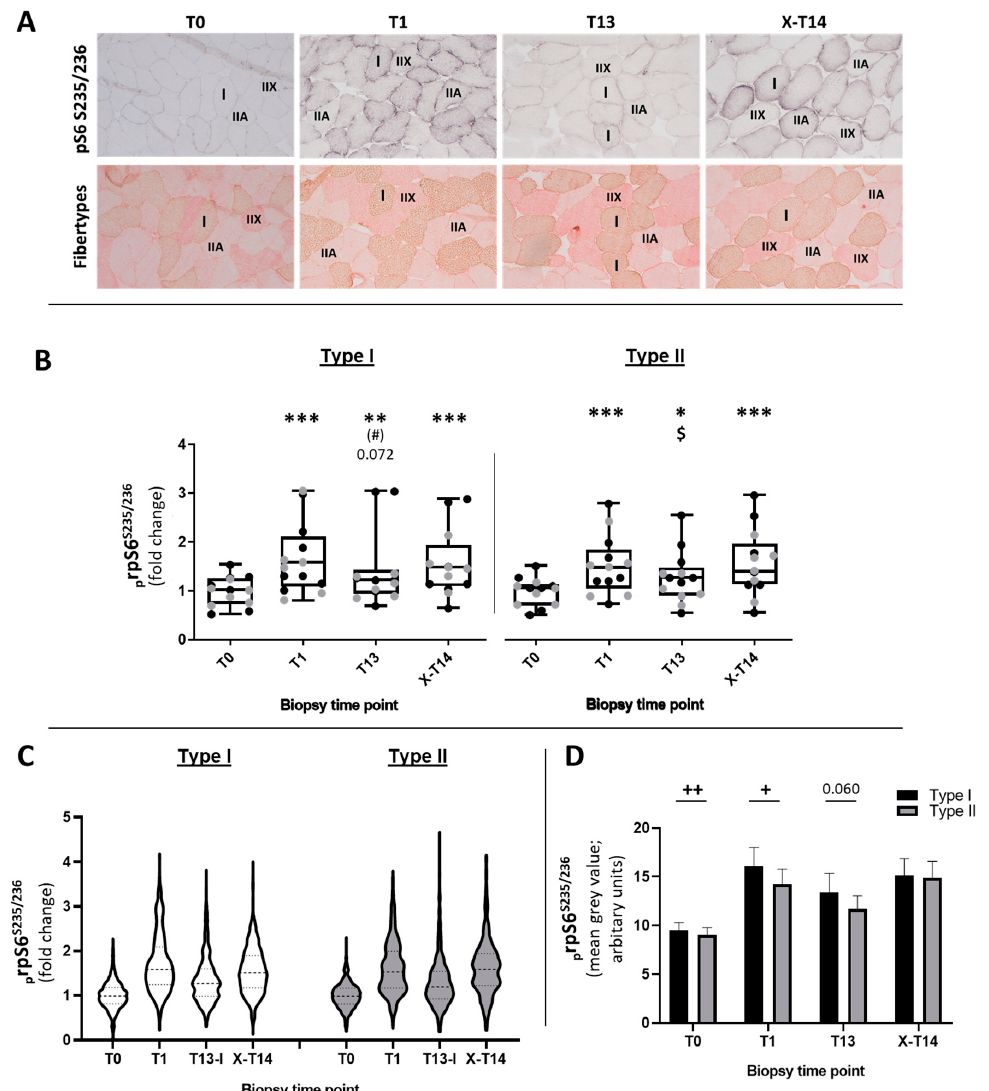
Figure 2. Quantification of the sarcoplasmic p rpS6 S235/236 staining intensity in type I and II myofibers as determined via densitometry. ( A ) Representative images of muscle cross-sections (20-fold mag- nification) from one subject stained for p rpS6 S235/236 (upper row of pictures) and the consecutive cross-section stained for type I (red–brown), type IIA (pale red), and IIX (full red) stained